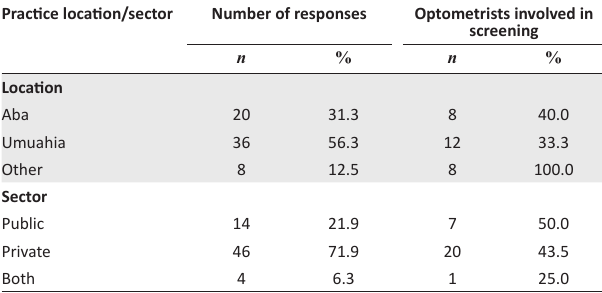
TABLE 1: Respondents demographics by practice location and setting as well as optometrists that have participated in at least one vision screening in the last 1